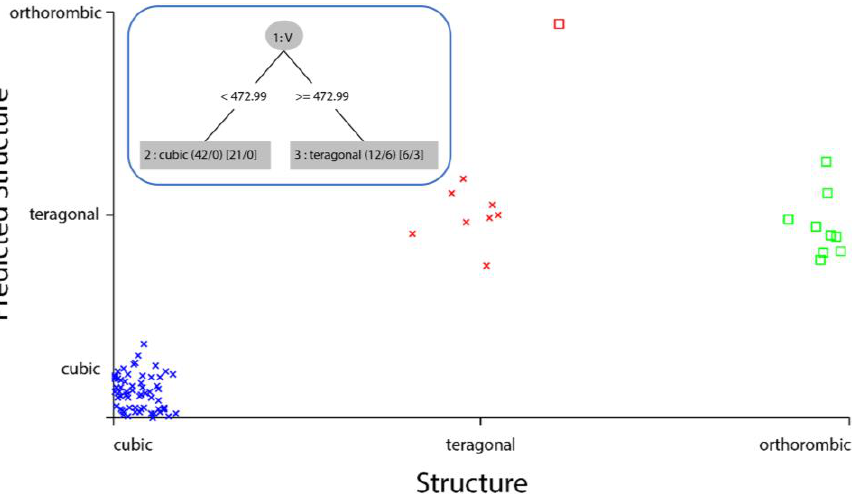
Figure 5. trees.REPTree classifier error visualization, where the cubic points are the error-classified structures (Inset: The tree from trees.REPTree classifier).